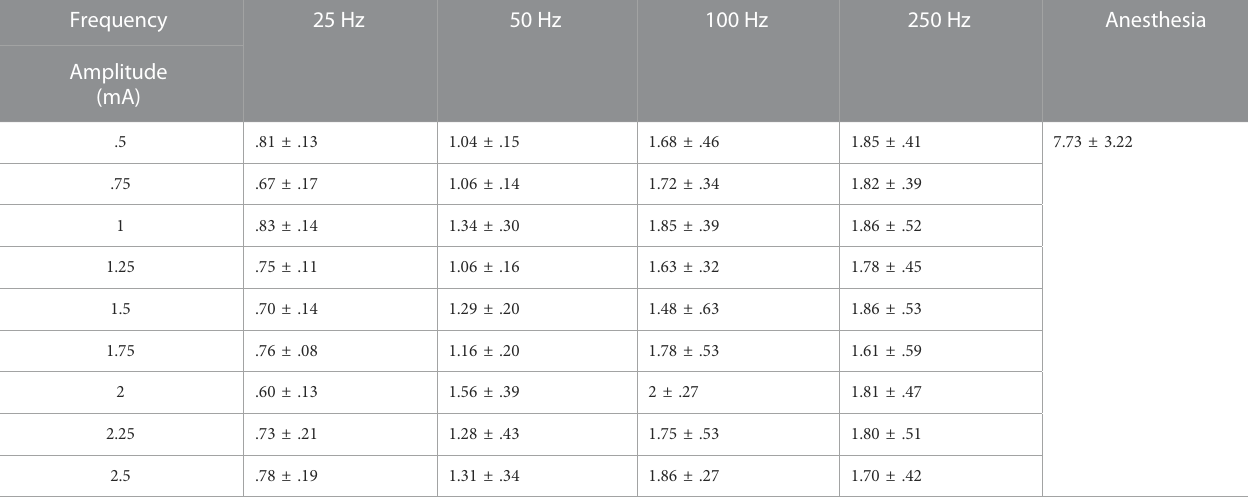
TABLE 1 Mean Air fl ow Index (b) calculated for inspiratory air fl ow waveforms during DP and anesthesia status. Frequency